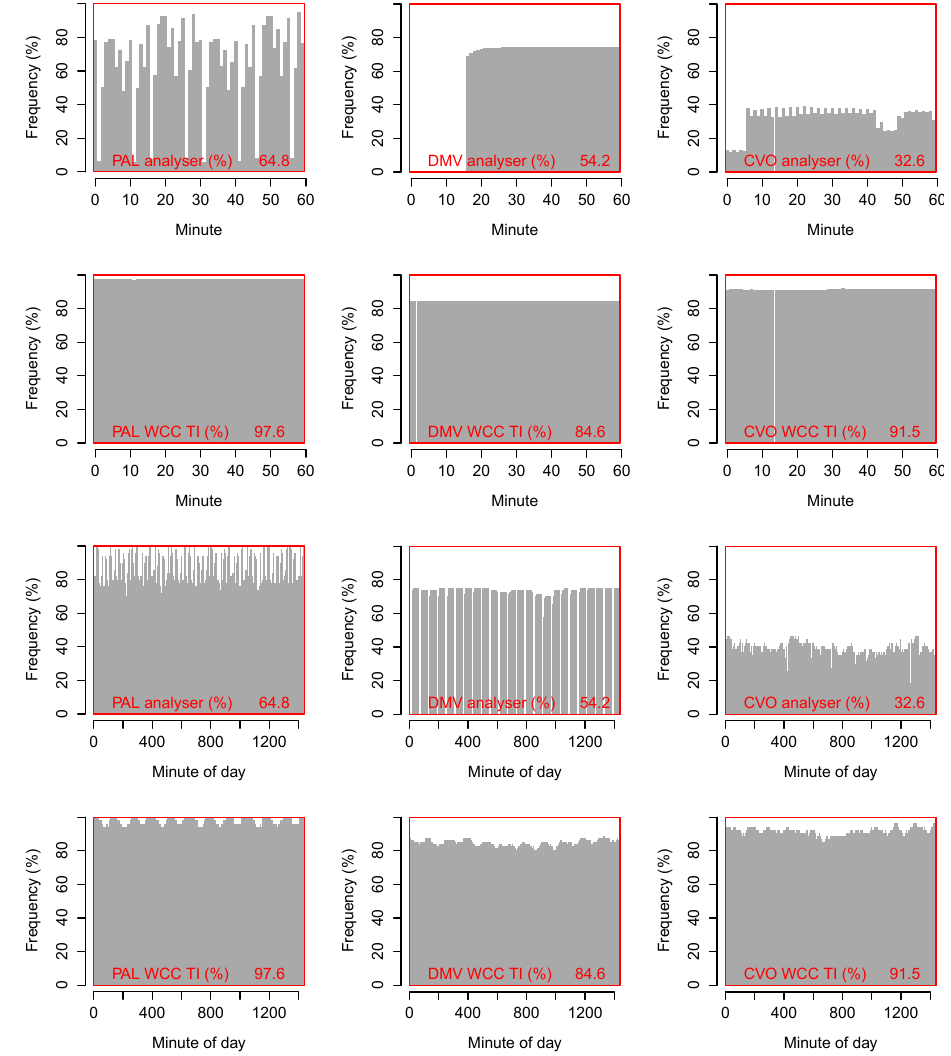
Figure 10. First row: mean CO 2 data availability of the PAL, DMV and CVO station instruments as a function of the minute of the hour. Second row: same as above, for the WCC-Empa travelling instrument. Third row: mean CO 2 data availability for the station instruments as a function of the minute of the day. Fourth row: same as above, for the WCC-Empa travelling